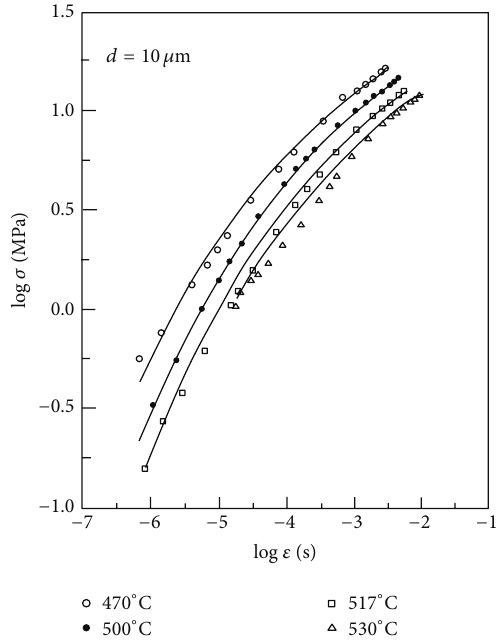
Figure 6: The effect of temperature on the flow behavior of 8090 Al-Li with the average grain size of 10 𝜇 m.